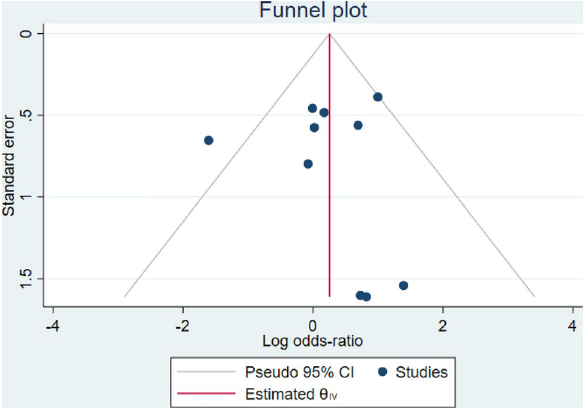
Figure 8. Funnel plot of effect size versus standard error in the 4–8 h